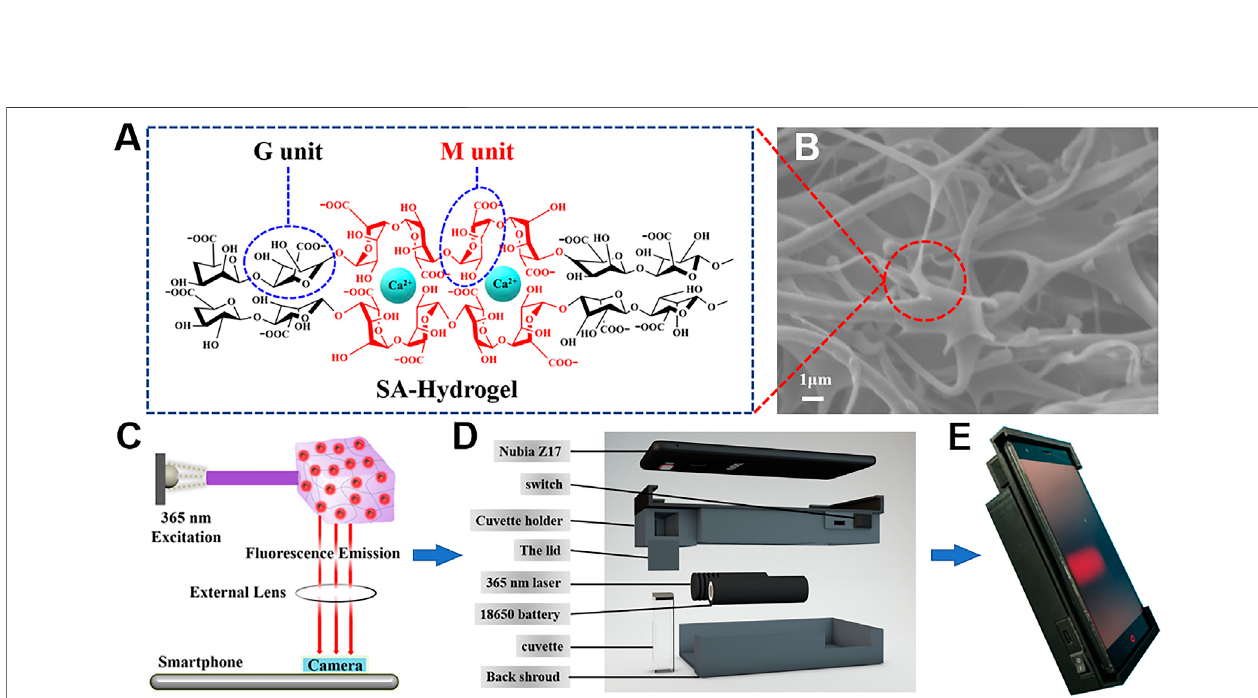
Frontiers in Chemistry |